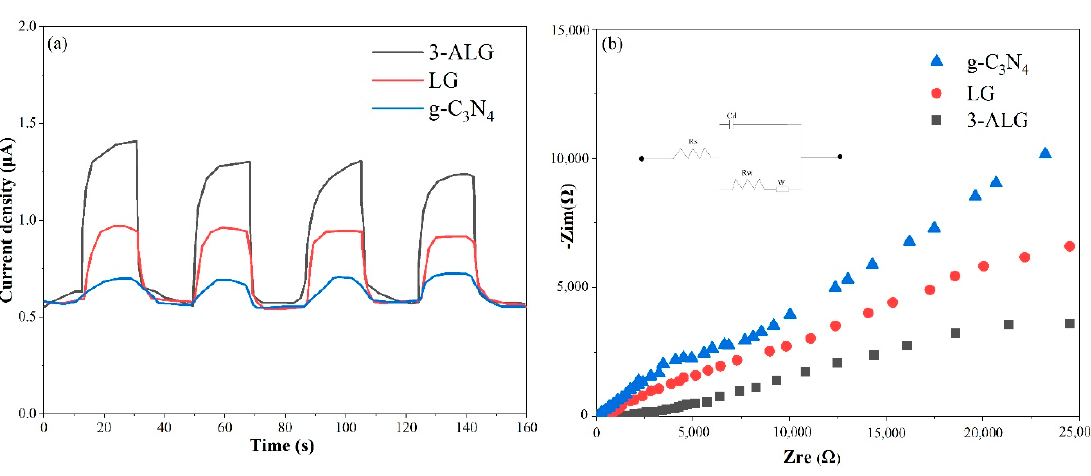
Figure 8. Photocurrent time curves ( a ) of g-C 3 N 4 , LG, and 3-ALG and EIS Nyquist plots ( b ).